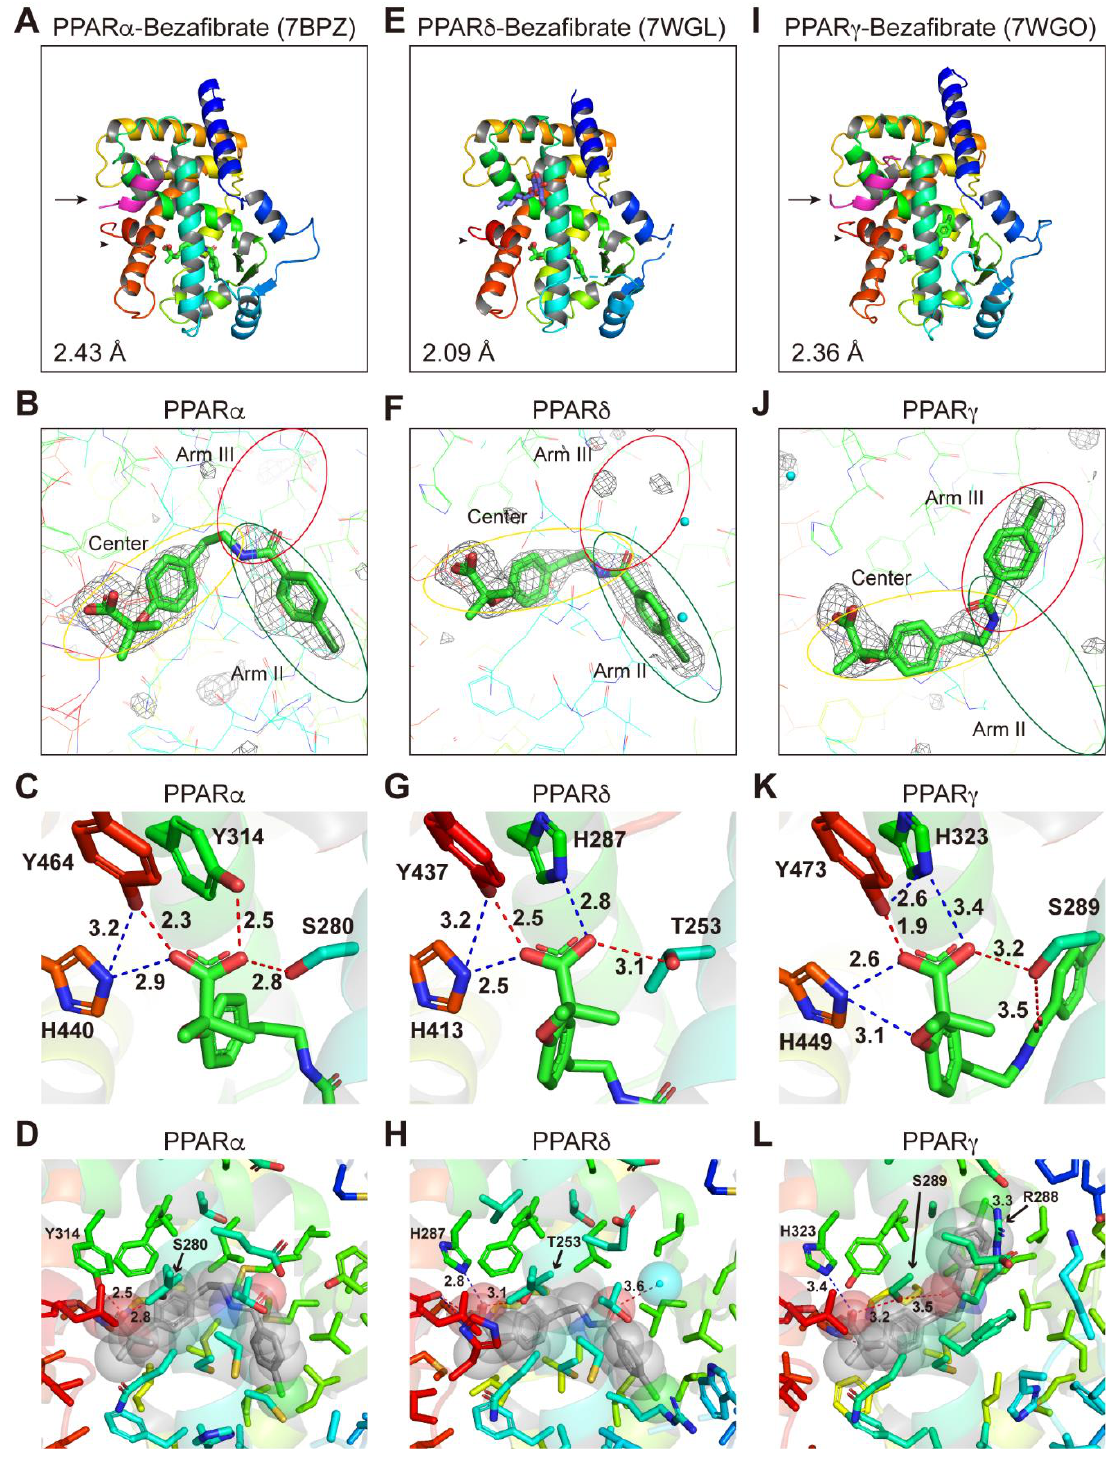
Figure 4. PPAR α / δ / γ -LBD – bezafibrate cocrystal structures. Cocrystals of bezafibrate and PPAR α - LBD ( A – D ; reprinted from Kamata et al. [6]), PPAR δ -LBD ( E – H ), or PPAR γ -LBD ( I – L ) were analyzed using X-ray diffraction. ( A , E , I ) Overall structures of the complexes. The SRC1 peptide ( α -helix in magenta) and the AF-2 helix 12 ( α -helix in red) are indicated by arrows and arrowheads, respectively. PDB identities and resolutions are labeled. ( B , F , J ) Magnified views of bezafibrate located in the Center/Arm II regions of PPAR α / δ -LBD ( B , F ) or the Center/Arm III regions of PPAR γ -LBD ( J ).